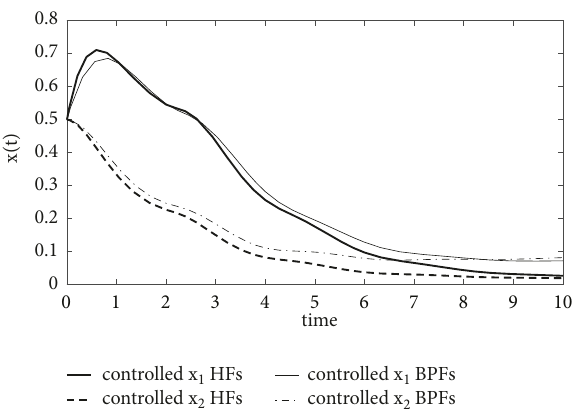
Figure 5: Optimal and suboptimal control signals. Figure 5 exposes optimal control and suboptimal state feedback control signals using